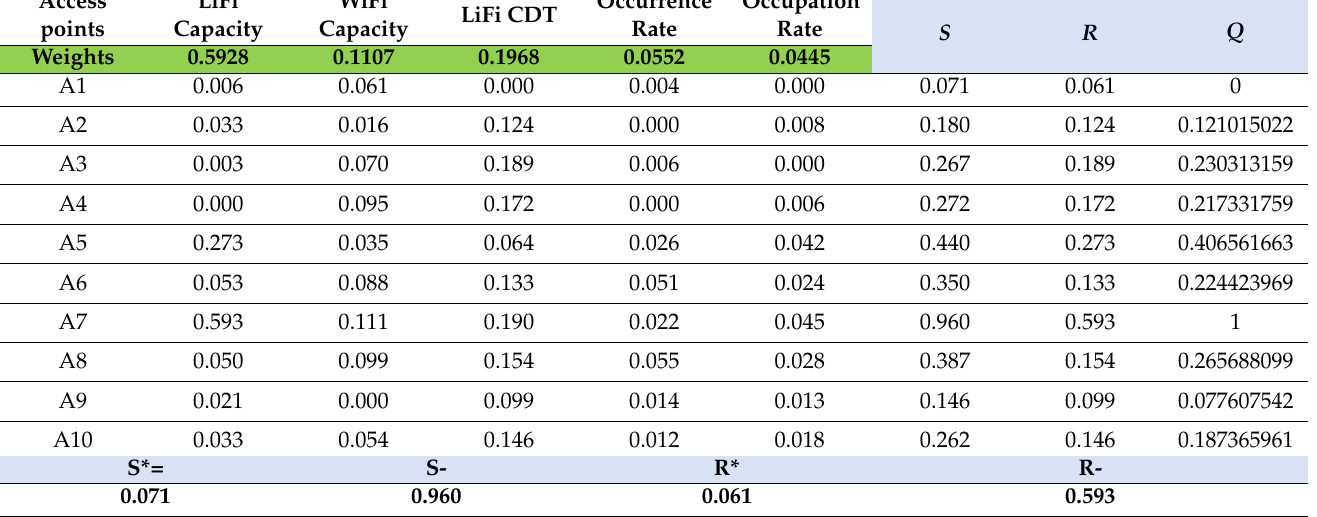
Table 21. VIKOR results after using weights of